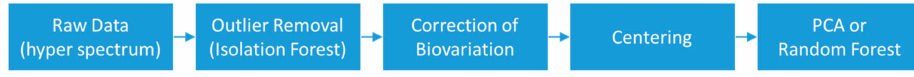
Figure 4. Flowchart of data pre-process of measured